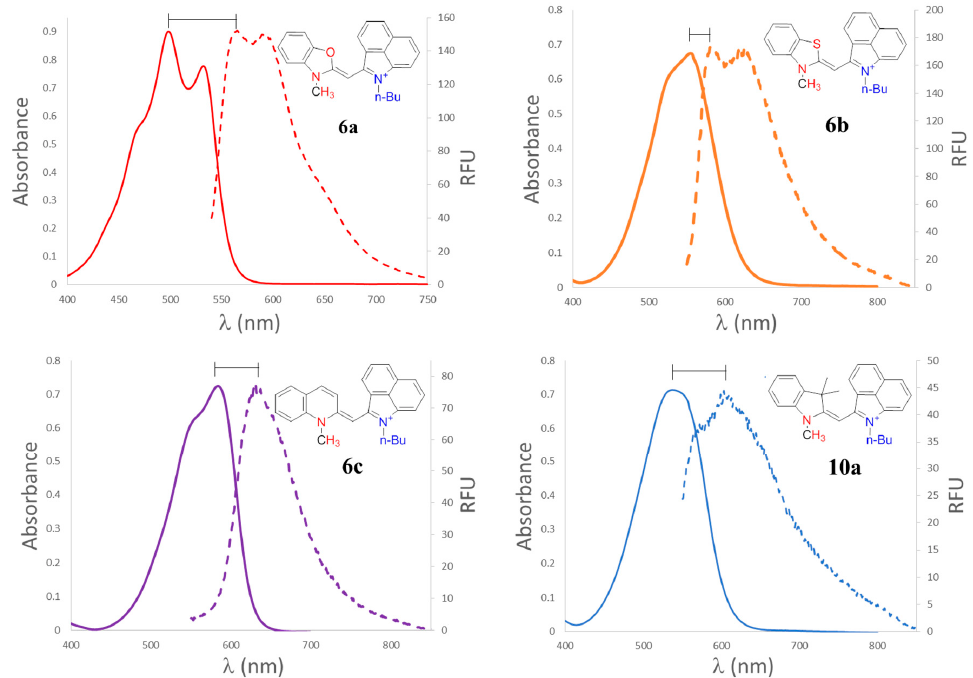
Figure 2. Absorbance (solid lines) and emission (dashed lines) in methanol/glycerol 9/1 spectra at 20 μ M.